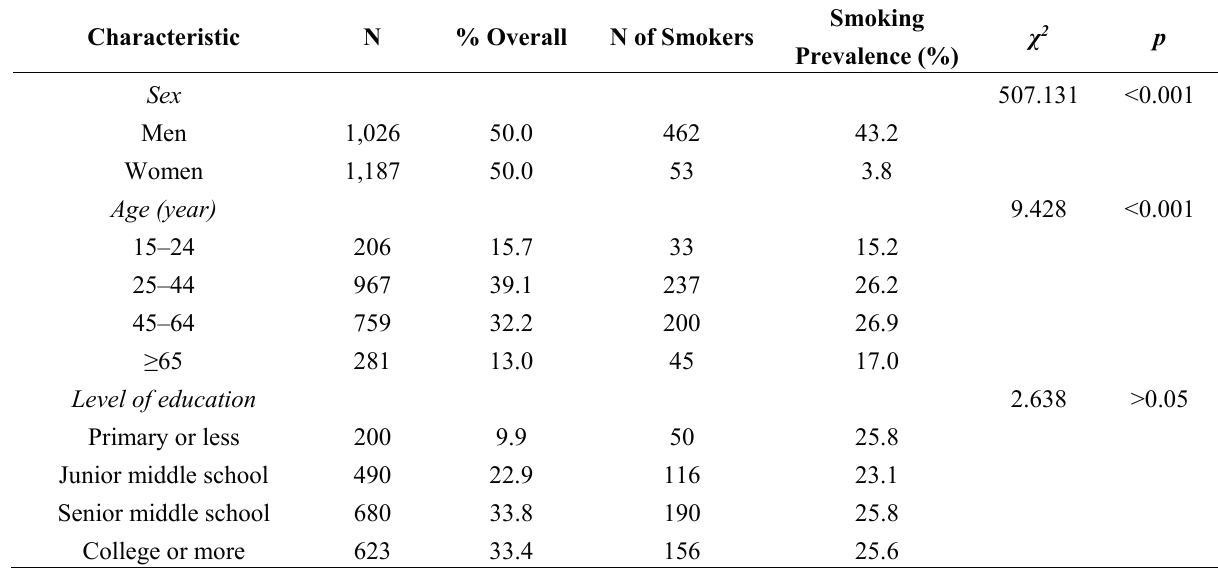
Table 2. Prevalence of tobacco consumption among current smokers by sex, age group and level of education.